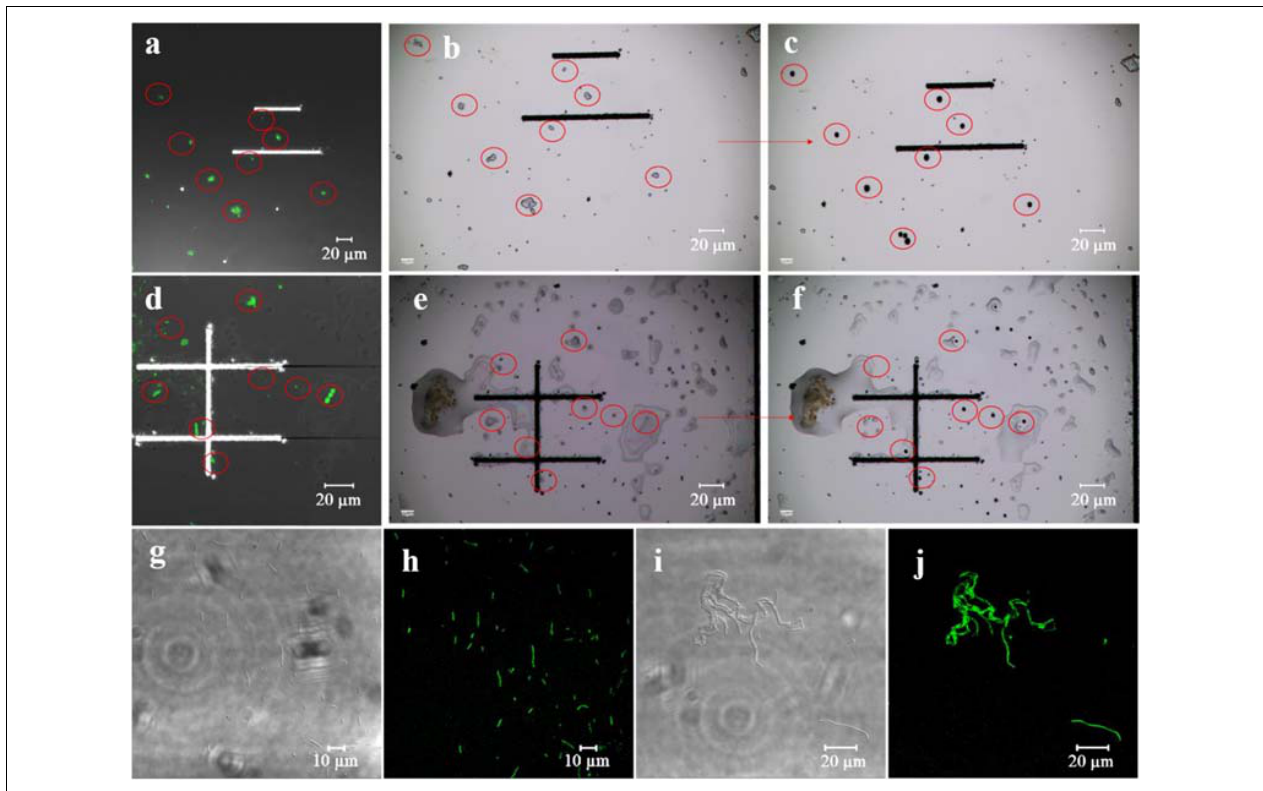
FIGURE 4 | Single-cell sorting of environmental samples. (a–f) Single-cell sorting; (a) (#31) and (d) (RG) are fluorescent images of the sorting chip, (b,e) indicate sorting chip images before sorting, and (c,f) represent sorting chip images after sorting. (g–j) Fluorescence verification; (g,h) are bright field and fluorescent images of sorted strain S1A1, and (i,j) correspond to the sorted strain RCA.